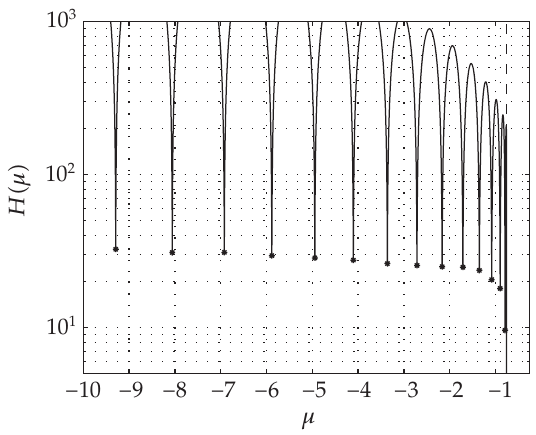
− Dp 2 [ . This conjectures Figure 3.1 The graph of H ( µ ) for µ ∈ [ − 10 , − a 4 that H has no zeros in the region µ < − a 4 − Dp 2 . The vertical axis is loga- rithmic, the stars ( ∗ ) denote local minimum values of H , and the dotted vertical line denotes the point µ = − a 4 − Dp 2 . One sees that the smallest local minimum value is approximately 10. The parameter values used in this plot are given in Table